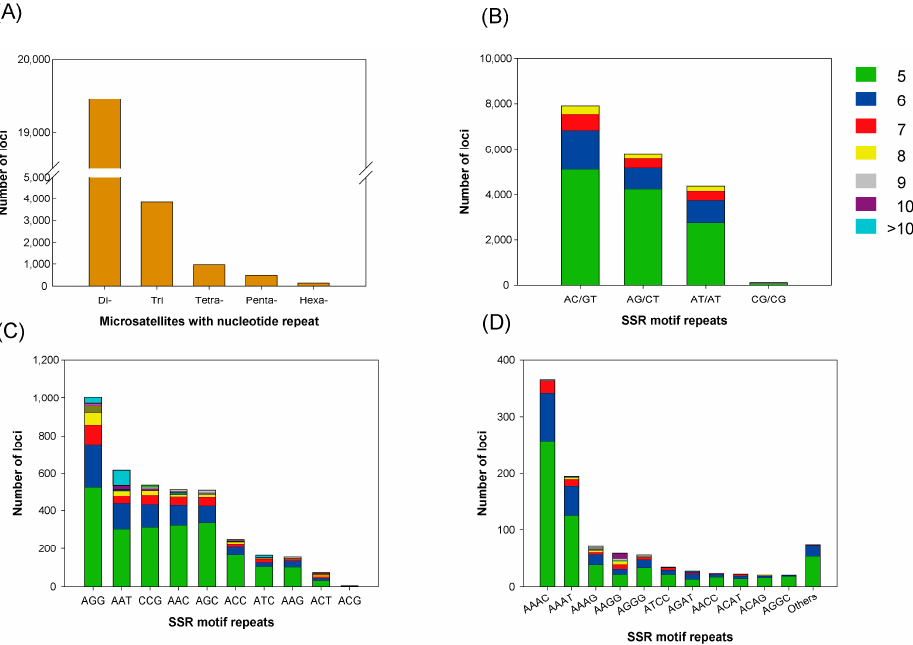
Figure 6. The distribution and frequency of microsatellite motifs. ( A ) Frequency of different microsatellite repeat types. ( B – D ) Frequency of different dinucleotide, trinucleotide, and tetranucleotide microsatellite motifs, respectively. The colors for ( B – D ) indicate the frequency of microsatellite mofits.